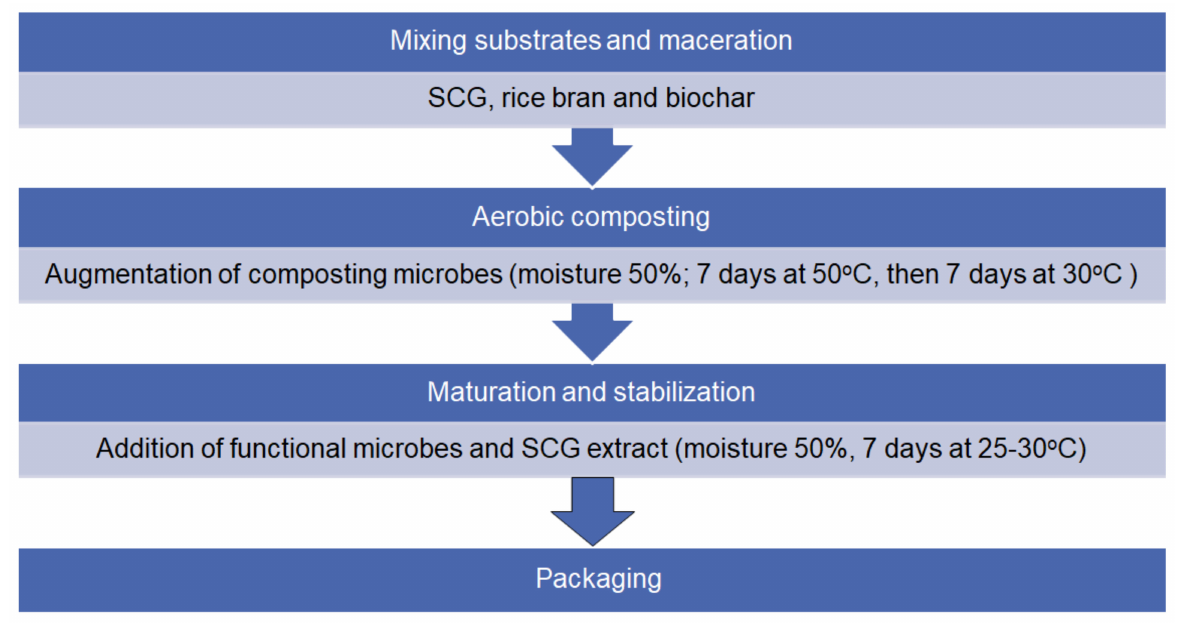
Figure 1. Manufacturing process of the functional composts using SCGs, rice bran, biochar, and functional